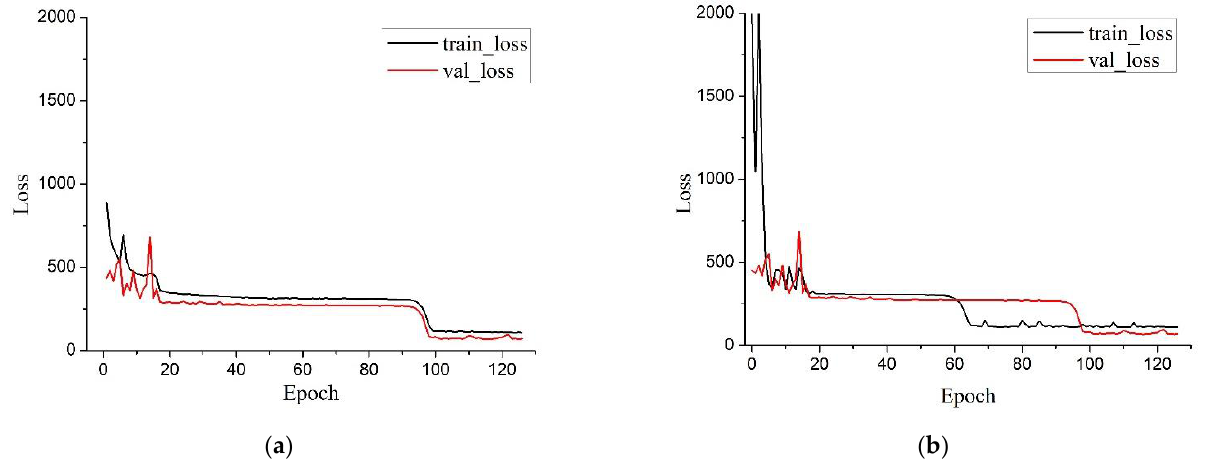
Figure 12. CNN network convergence of the loss functions. ( a ) RMSProp optimizer; ( b ) SGD optimizer.